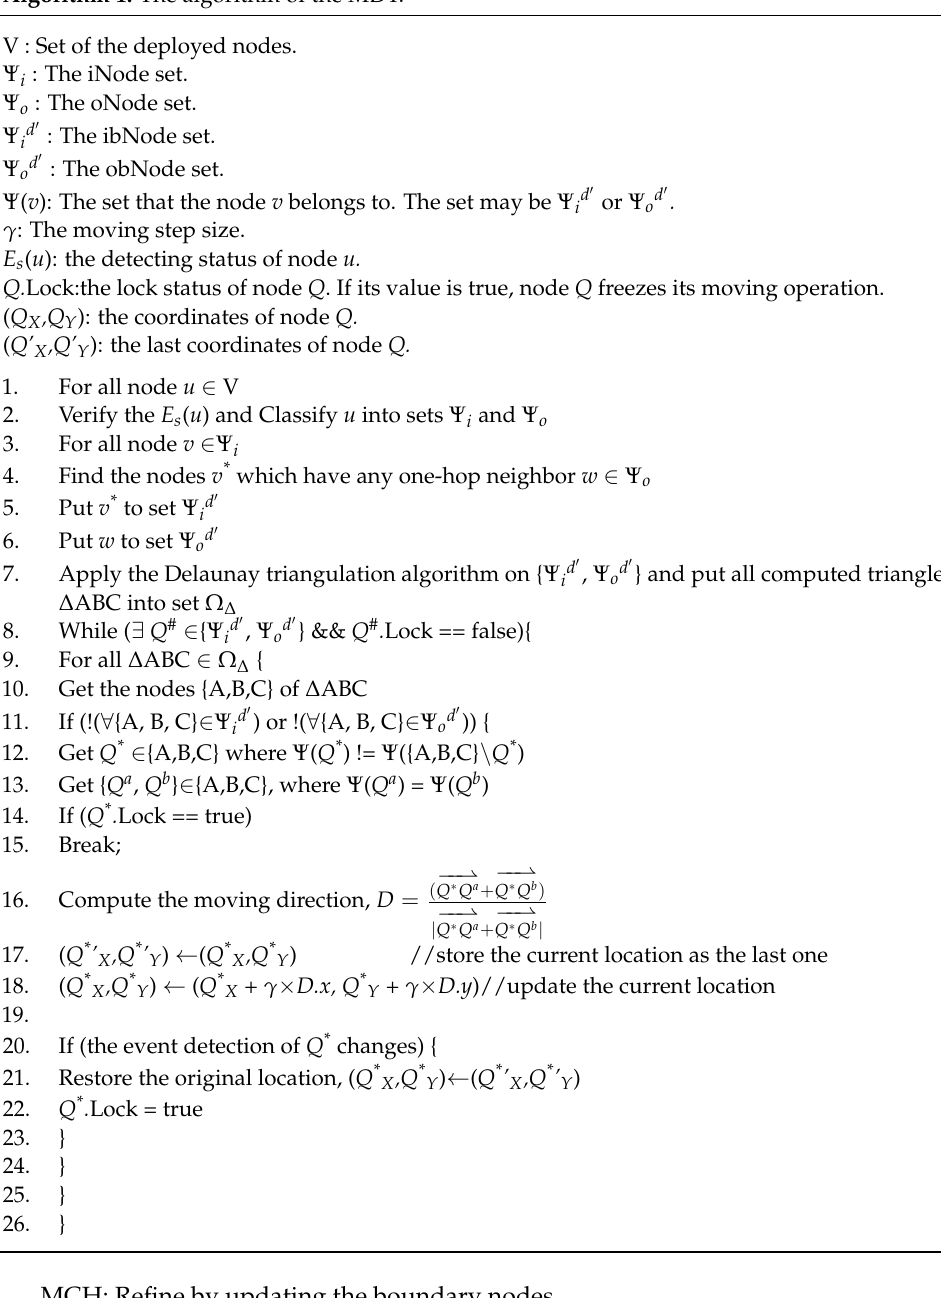
Algorithm 1. The algorithm of the